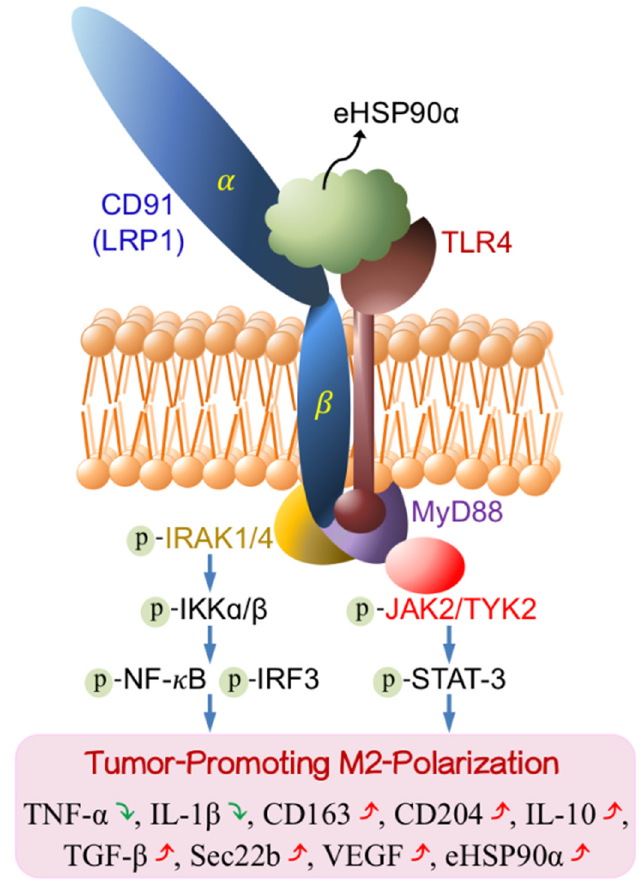
Figure 7. Schematic summary of eHSP90 α -induced CD91 and TLR4-associated signal transduction pathways for tumor-promoting M2-polarization in macrophages. Once macrophages are exposed to eHSP90 α , CD91 is enhanced to be physically associated with TLR4 to recruit IRAK1/4 and MyD88. Besides the canonical CD91/MyD88–IRAK1/4–IKK α / β –NF- κ B/IRF3 signaling pathway, JAK2 and TYK2 are recruited onto MyD88 to turn on a MyD88 − JAK2/TYK2 − STAT-3 pathway. Both signaling axes act together leading to downregulation of inflammatory cytokines TNF- α and IL-1 β as well as upregulation of M2-associated TGF- β , CD163, CD204, IL-10, and VEGF expressions. Following our previous report that the eHSP90 α -induced MyD88 − JAK2/TYK2 − STAT-3 pathway is involved in a feedforward loop of HSP90 α expression and secretion, this signal transduction pathway is also responsible for the induction of Sec22b expression to decrease the phagocytotic activity of macrophages. Green ↓ , down-regulated. Red ↑ , up-regulated.